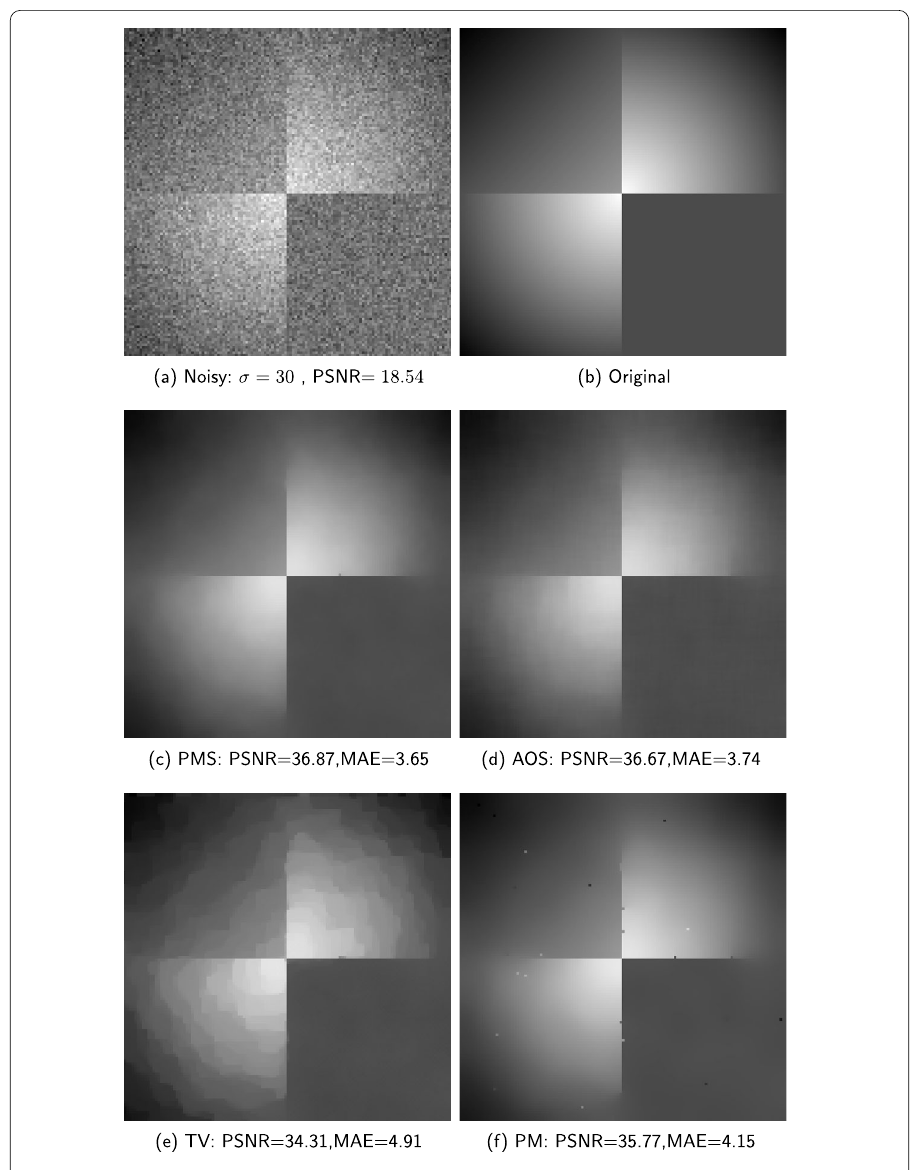
Figure 1 Synthetic image (128 × 128): ( a ) noisy image corrupted by Gaussian noise for σ = 30; ( b ) original image; ( c ) our algorithm by PMS, μ 1 = 0.5, μ 2 = 0.5, and τ = 0.2; ( d ) our algorithm by AOS, μ 1 = 0.9, μ 2 = 0.1, and τ = 2; ( e ) TV algorithm, τ = 0.2; and ( f ) PM algorithm, τ = 0.2 and K =